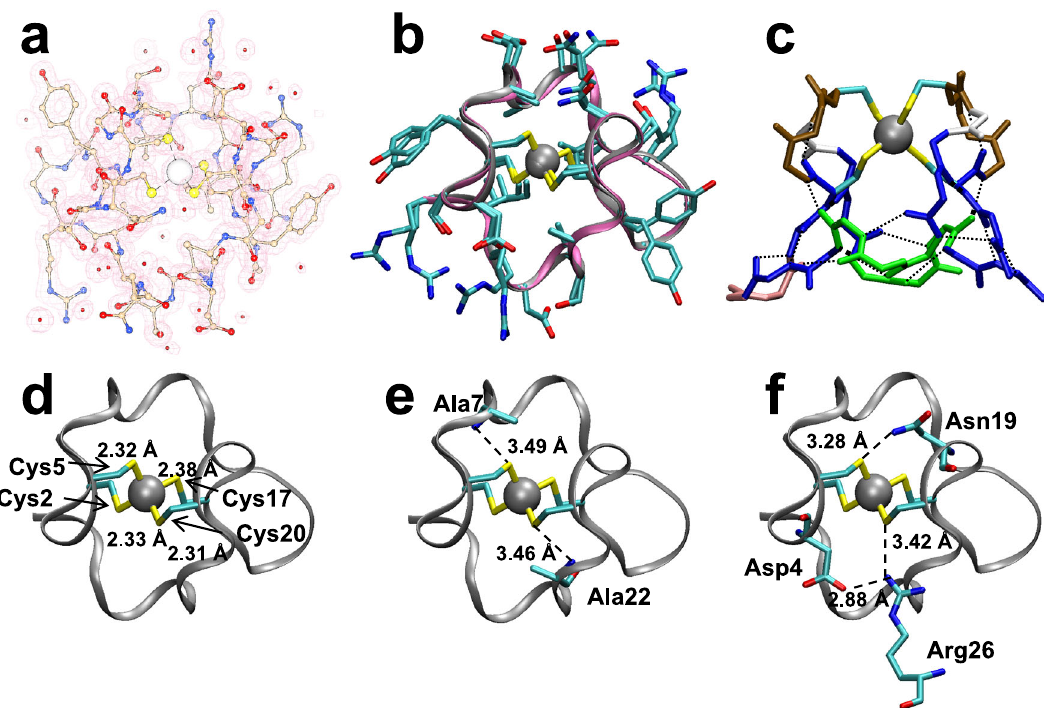
Fig.3|ZnMETPsc1structuralcharacterization.a Metalion,allsidechains,andN- and C-terminal capping groups are clearly visible in the electron density map (2 F o - F c .map,1.3 σ level). b ThemonomericX-raystructureofZnMETPsc1(cyan,this work, PDB ID: 5SBG) closely matches the designed model (light brown). c Description of secondary structural elements found in ZnMETPsc1 structure (blue: β -strand; ocre: α -turn; gray: β -bulge; green: 3 10 -helix; orange: type I ’ β -turn).